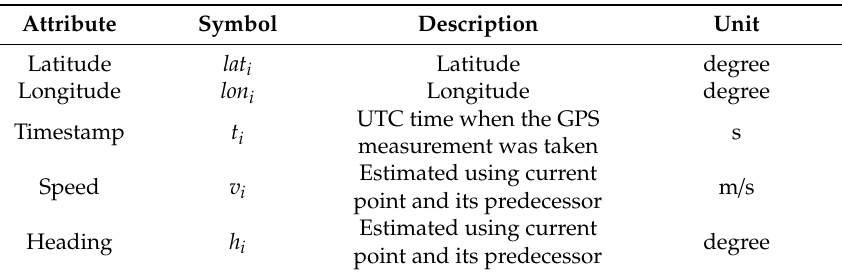
Table 1. Attributes of each GPS point x i .